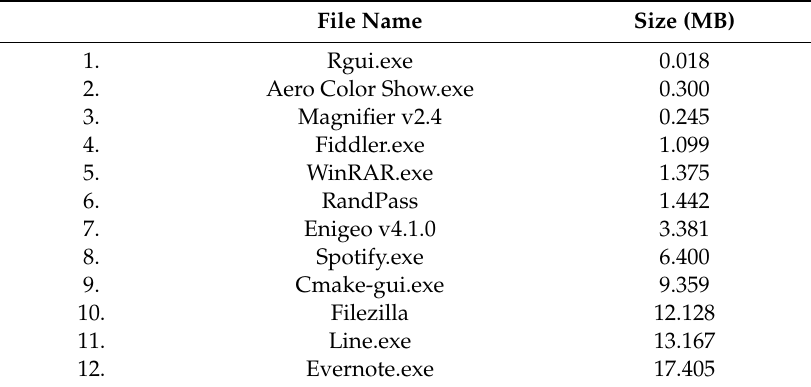
Table 3. Information of test